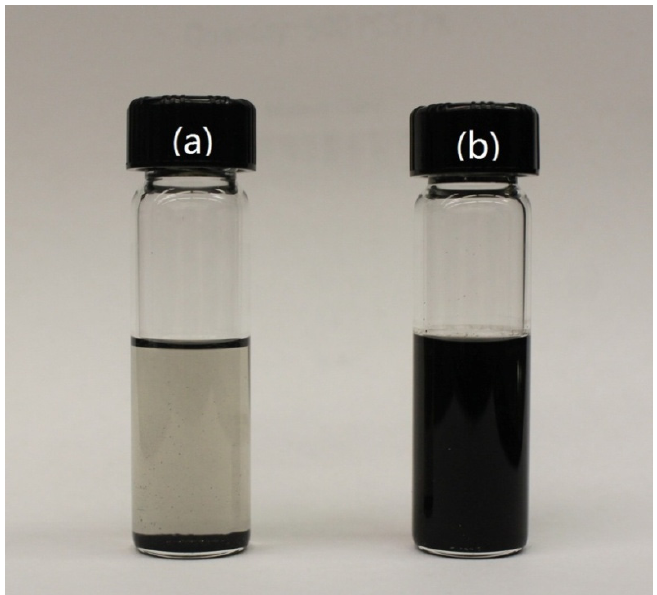
Figure 1. Digital photos of the solubility of CNTs ( a ) and CNTs ‐ PA ( b ) in CHCl 3 .